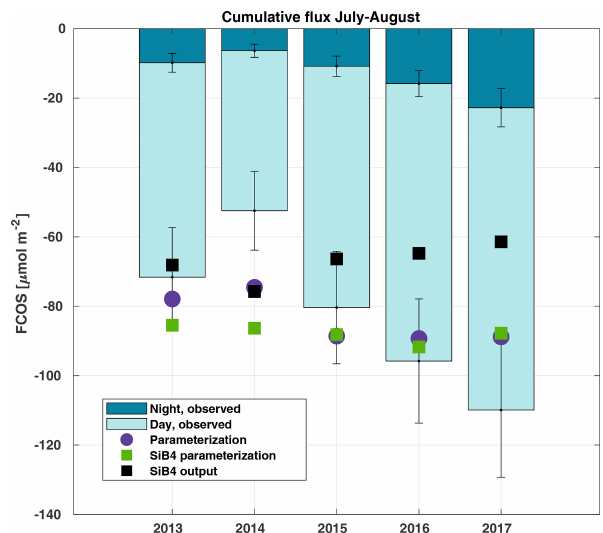
Figure 6. Cumulative sum of the gap-filled carbonyl sulfide flux (FCOS) in 2013–2017 during the July–August period, separated into day and night contributions. The percentage of gap-filled COS data during nighttime and daytime, respectively, was 77% and 58% in 2013, 70% and 45% in 2014, 57% and 38% in 2015, 65% and 43% in 2016, and 55% and 29% in 2017. Purple circles represent the parameterized FCOS, green squares represent the parameteriza- tion by SiB4, and black squares represent the standard SiB4 output for